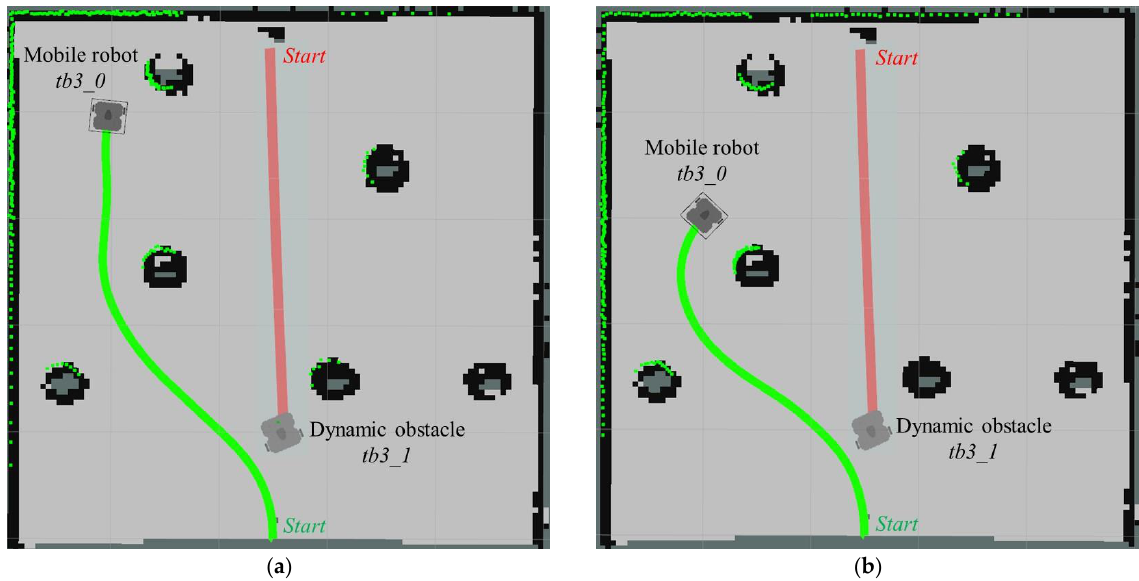
Figure 16. ( a ) Rviz simulation for dynamic environment scenario 1 after testing the LSTM model with goal point of ( 1.0,4.0 ) for 𝑡𝑏3_0 , ( b ) Rviz simulation for dynamic environment scenario 1 after testing the LSTM model with goal point of ( 1.0,3.0 ) for 𝑡𝑏3_0 .